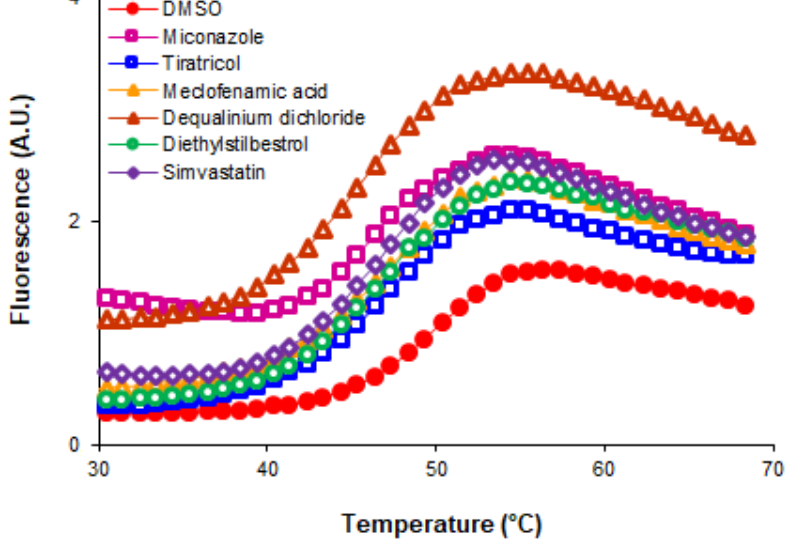
Figure 1. Temperature denaturation profiles of ArsR without added ligands (DMSO) and after the addition of 250 µM of the several ligands (open symbols). Data points (symbols) are experimental observations; the lines are fits to a two-state unfolding model.